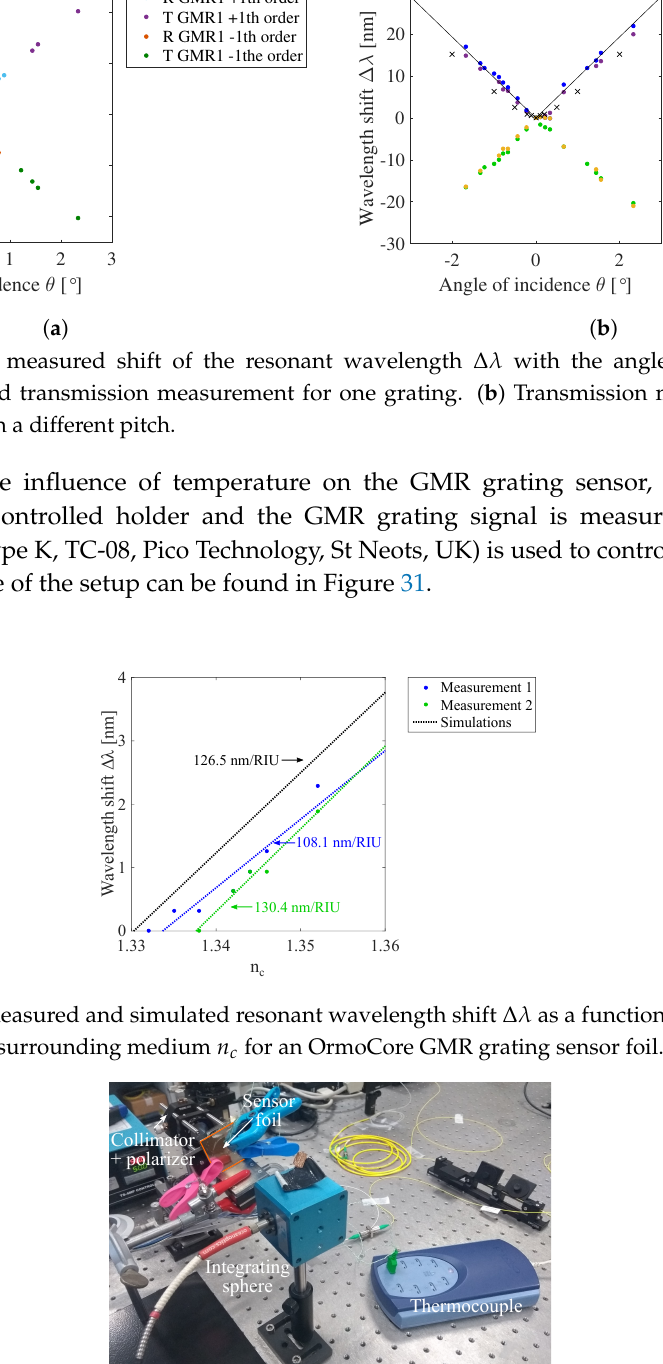
Figure 31. The setup to measure the temperature sensitivity of GMR grating sensor foils in transmission with a thermocouple as